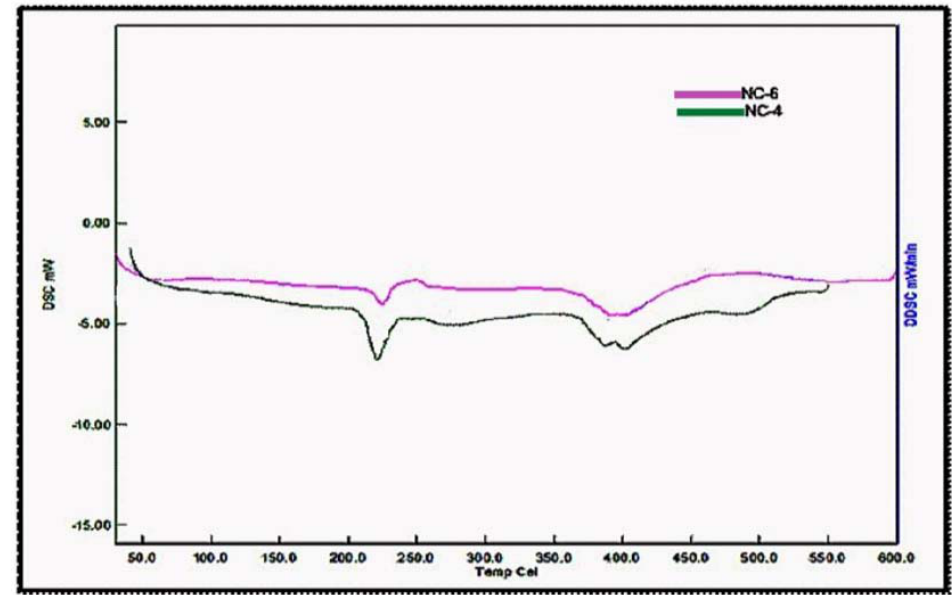
Figure 8. Differential scanning calorimetry micrographs of hybrid nanocomposites hydrogels (NCHs). Figure 8. Di ff erential scanning calorimetry micrographs of hybrid nanocomposites hydrogels